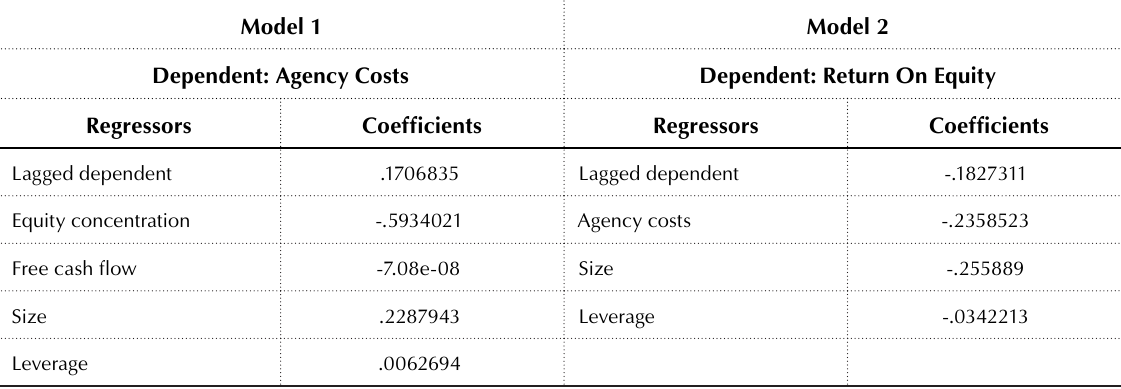
Table 2. Results of dynamic panel data two-steps robust system